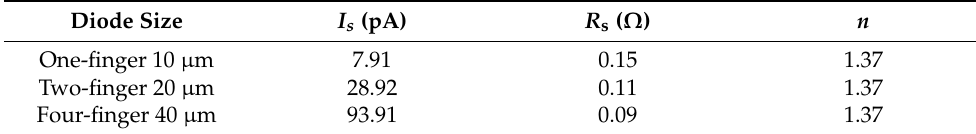
Table 1. DC parameter of diodes with different